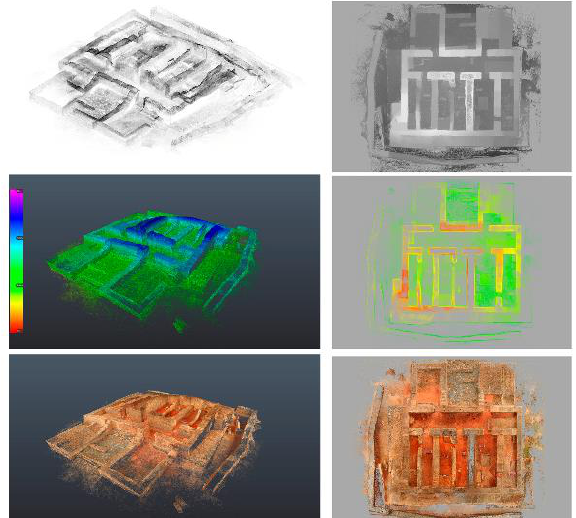
Figure 3. Image of the digital processing of the Tartessian building of La Mata (Campanario). The level of detail achieved in the data acquisition process means it is possible to make measurements and metrological studies, as well as to analyse the presence of construction techniques that are imperceptible in field analysis. To achieve a greater degree of detail, in addition to the planimetric documentation, all spaces and structures are scanned in 3-D using a phase-shift laser scanner that provides us with a cloud of high-density points that gives us valuable information about the size of the individual elements, absolute distances and locations of an element or relative distances between several, visualisation of the work, colour information associated with different elements, etc.